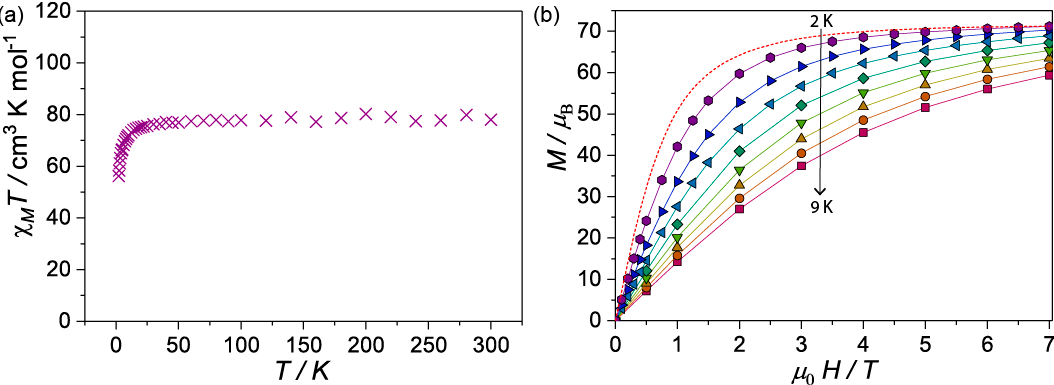
Figure 4. ( a ) Variation of χ M T vs. T for 1 at 1kOe from 2–300 K; ( b ) M β vs. H for 1 at different temperatures (2–9 K) in the field range comprising 0 to 7 T. Dotted line is the Brillouin function at 2 K for ten isolated Gd(III) ( g J = 2.00 and S = 7/2).